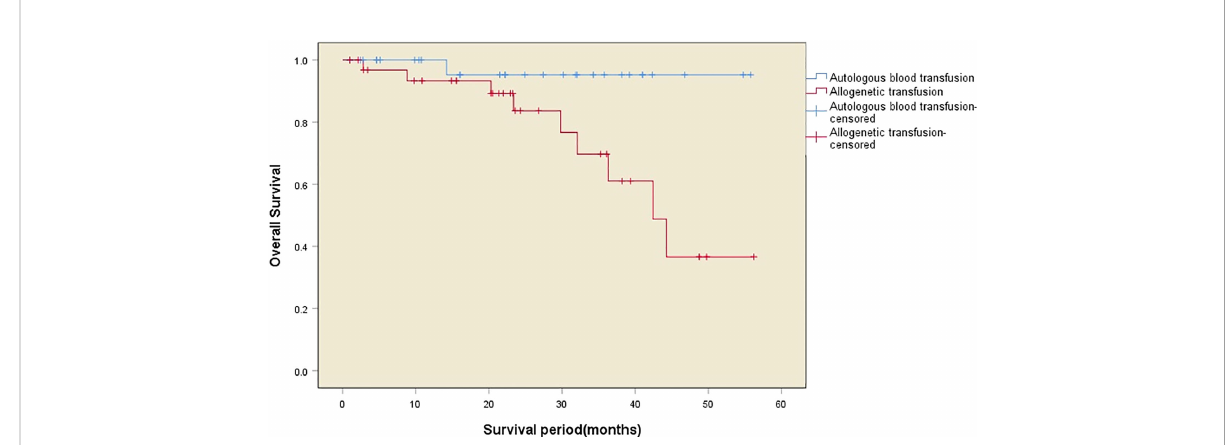
FIGURE 2 Kaplan – Meier curves showing the overall survival of the patients in the two